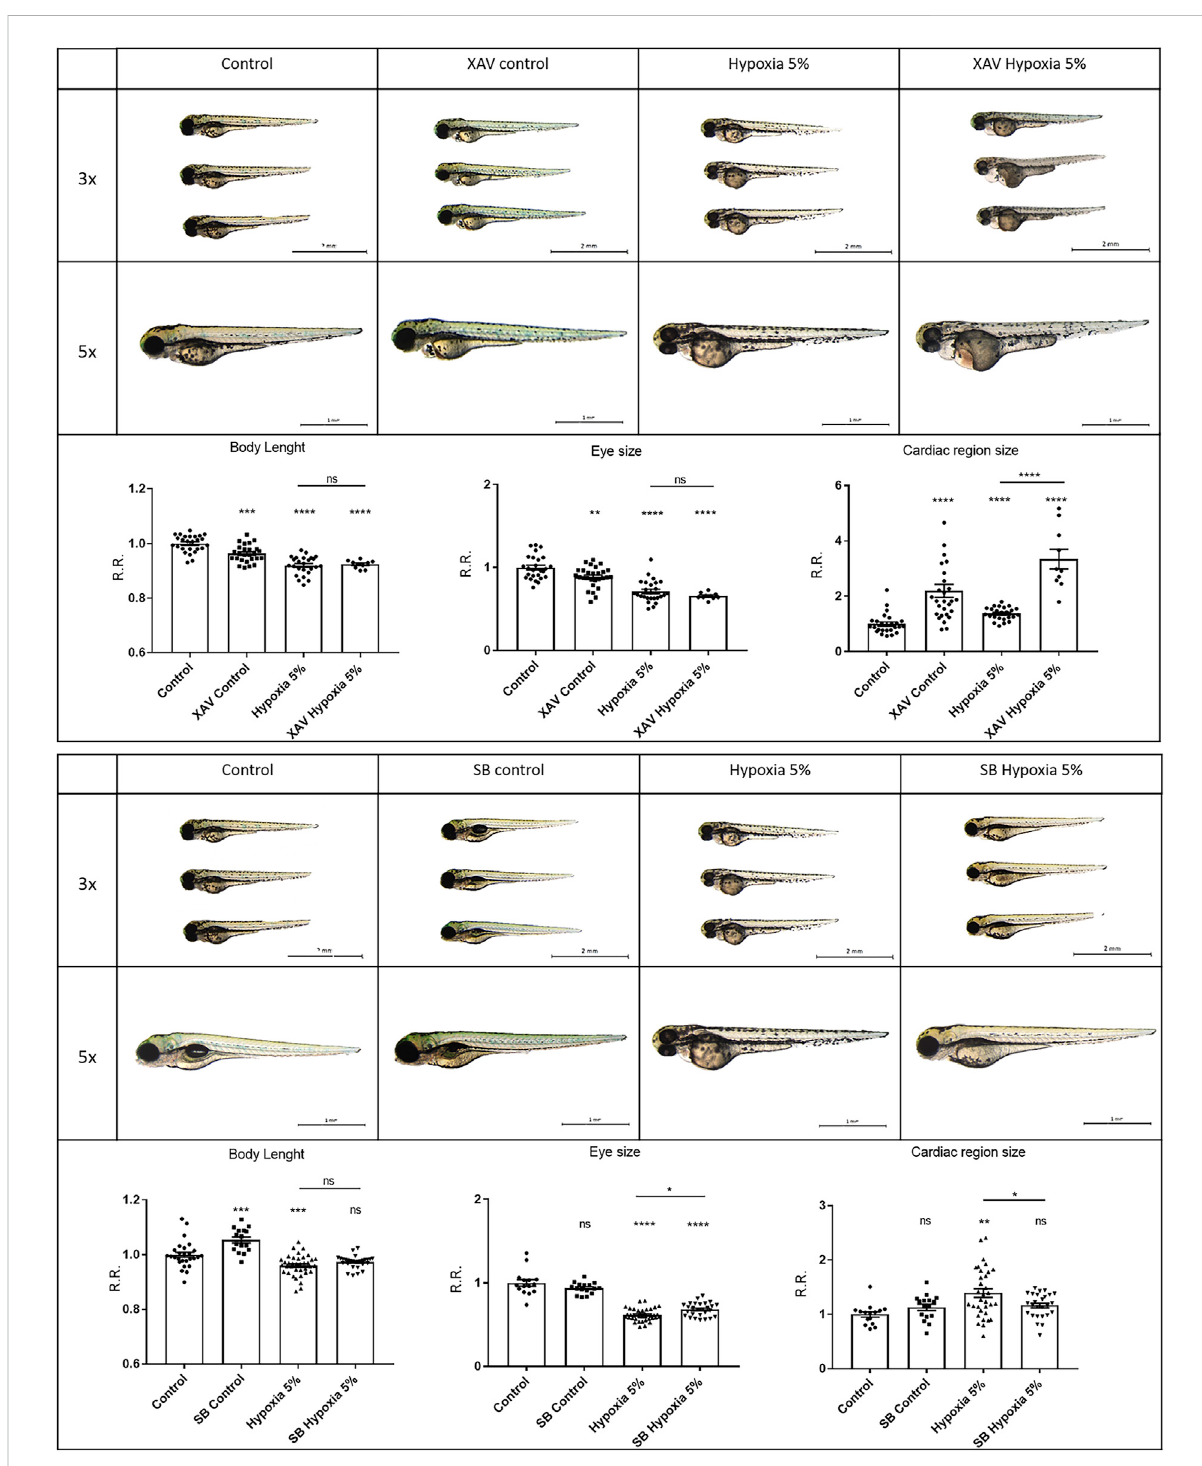
FIGURE 6 Wnt/ β -catenin signalling upregulation can rescue FGR anomalies. Downregulation of Wnt/ β -catenin signalling with 5 µM XAV939 (XAV) inhibitor does not rescue body length or eye size, and worsens the pericardial effusion under hypoxia. Upregulationof Wnt/ β -catenin signalling with 40 µM SB216763 (SB) agonist can rescue the body length and the pericardial effusion under hypoxia. All embryos, at 3 dpf, are displayed in lateral view, anterior to the left. For display purposes, images of control embryos under normoxia and hypoxia correspond to control images of Figure 5, as the same control conditions were used for both Stat3 and Wnt experiments. Sample size: n = 15; * = p < 0.05; ** = p < 0.01; *** = p < 0.001; **** = p < 0.0001; ns = not signi fi cant; R.R. = Relative Ratio. Test: One-way ANOVA followed by Tukey ’ s test.